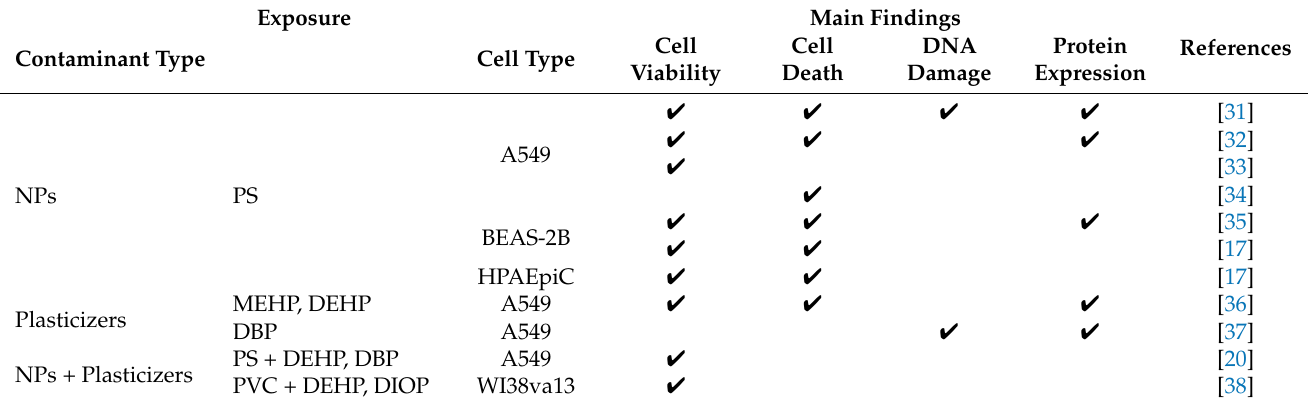
Table 2. List of papers reviewed clustered according to exposure type and the main findings.